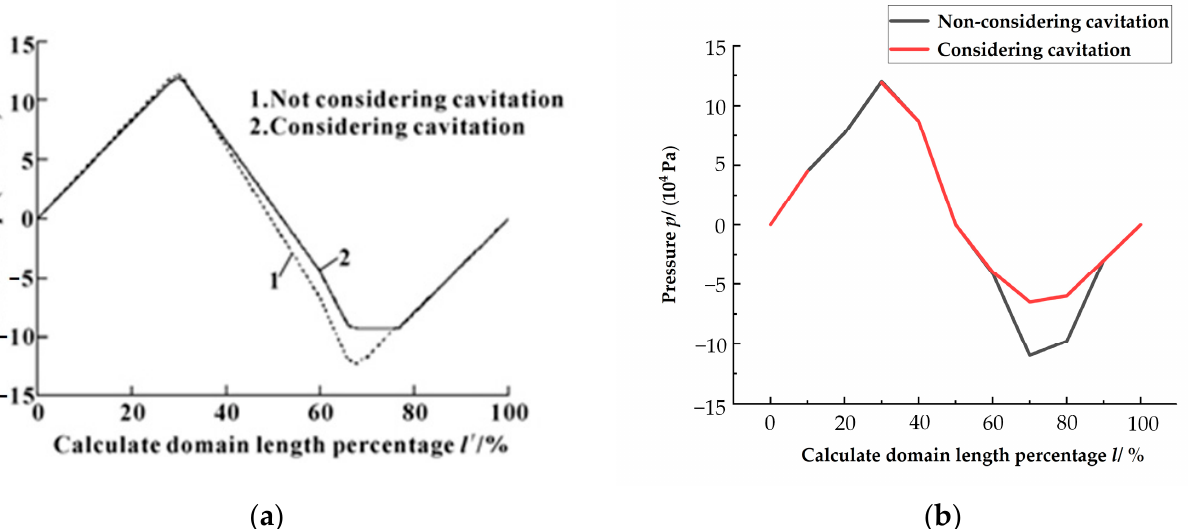
Figure 6. Verification of the calculation solver. ( a ) Pressure distribution obtained in the literature [20]; ( b ) Pressure distribution obtained by the calculation method in this paper.